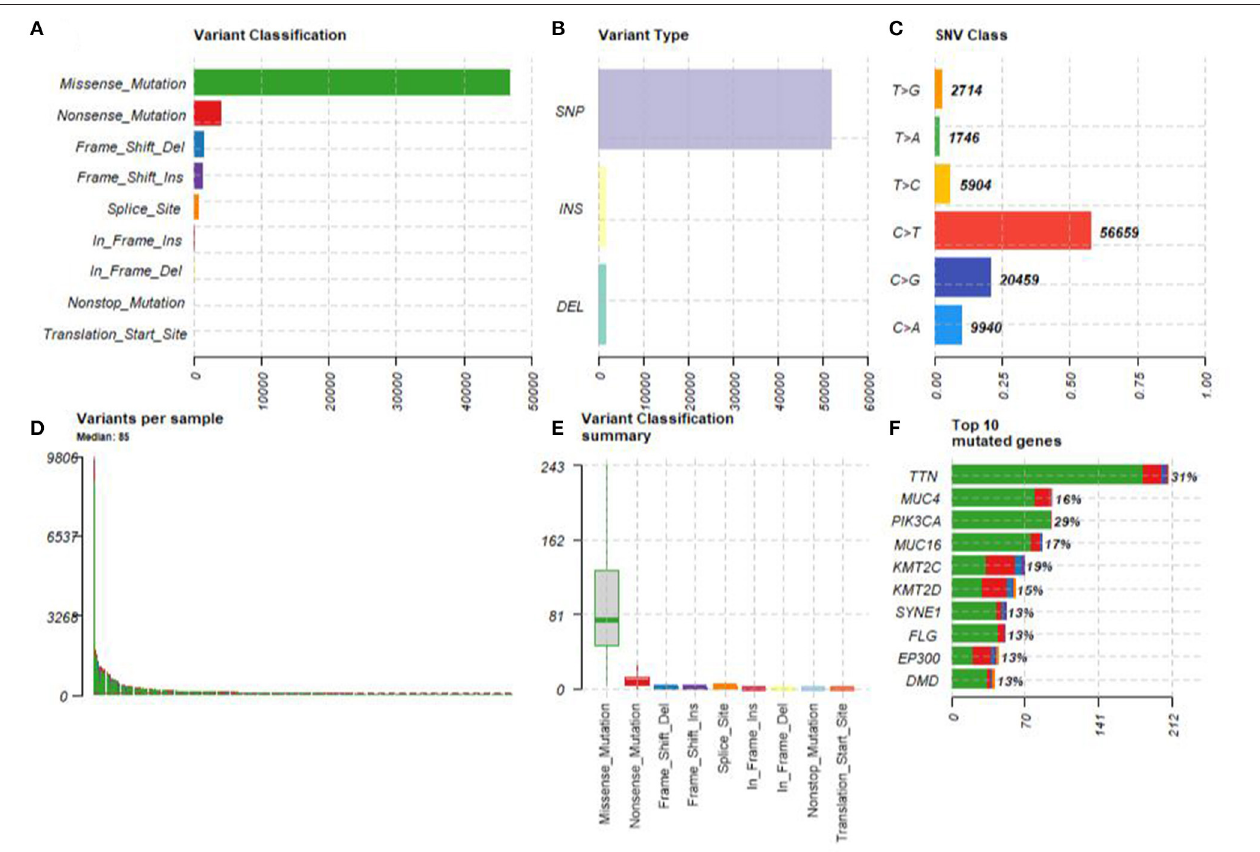
FIGURE 2 | The summary of the TCGA CESC maf file. (A) The most common mutation was missense mutation, followed by nonsense mutation, frame shift del, frame shift ins, splice site, in-frame ins, in-frame del, and translation start site. (B) The most common variant type was single nucleotide polymorphism (SNP), followed by INS and DEL. (C) The most common SNV variant was C > T, followed by C > G, C > A, T > C, T > G, and T > A. (D) The number of variants per sample was 85. (E) The median missense mutation per sample was 74, followed by nonsense mutation, frame shift del, frame shift ins, splice site, in-frame ins, in-frame del, and translation start site. (F) The top 10 mutant genes were TNN, MUC4, PIK3CA, MUC16, KMT2C, KMT2D, SYNE1, FLG, EP300, and DMD.